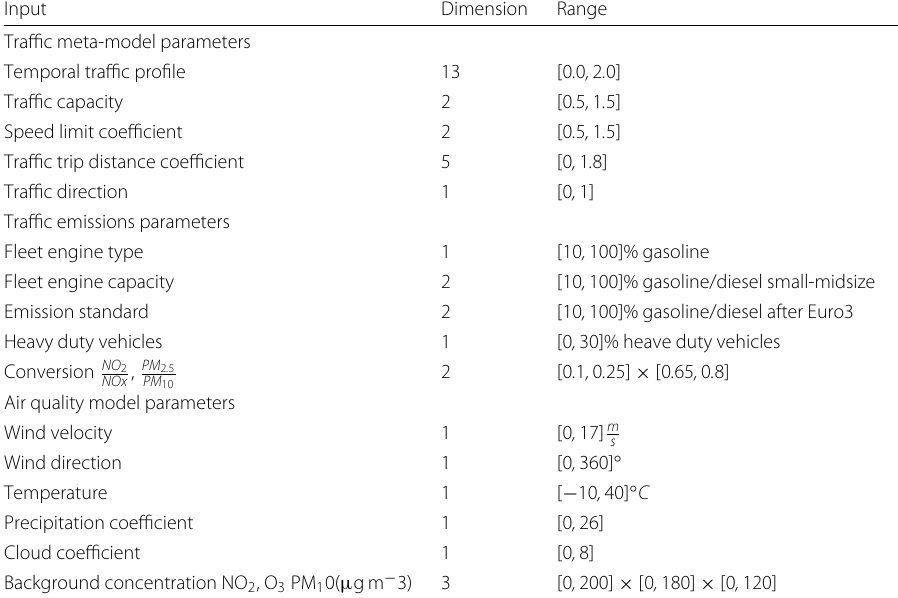
Table 2 Model chain input parameter